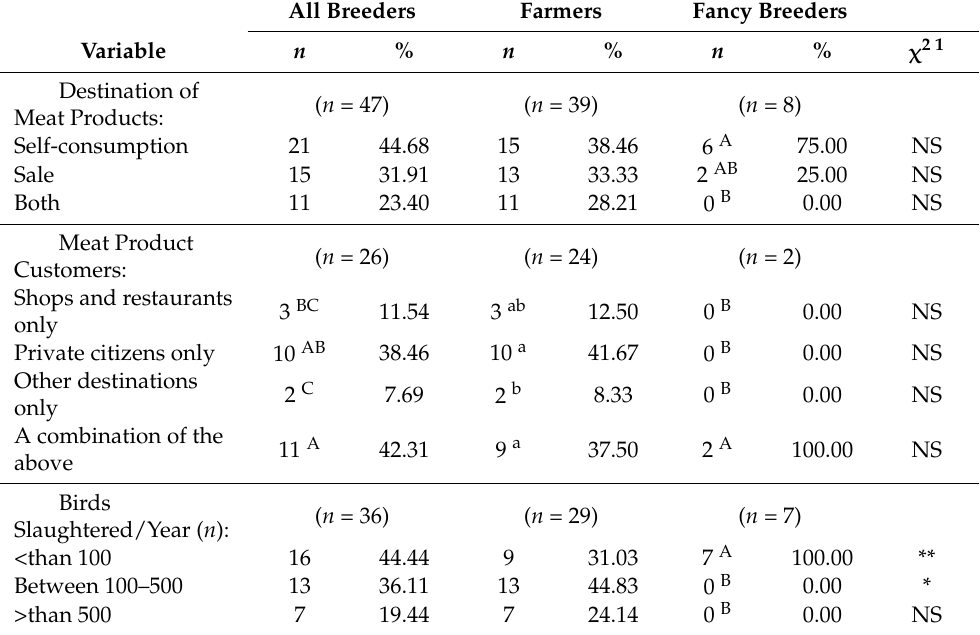
Table 3. Destination of Italian chicken breed meat products (self-consumption vs sale) and the distribution between different categories of customers: responses from all breeders and divided according to breeder category. All Breeders